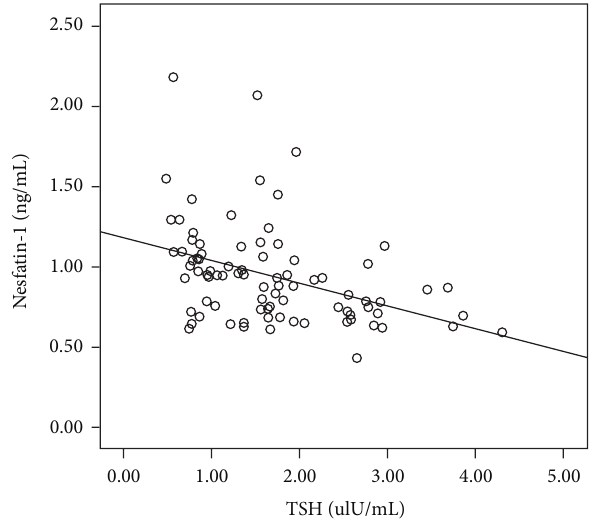
Figure 2: Negative correlation of the plasma nesfatin-1 level with the plasma TSH level ( 𝑟 = −0.404 , 𝑃 < 0.01